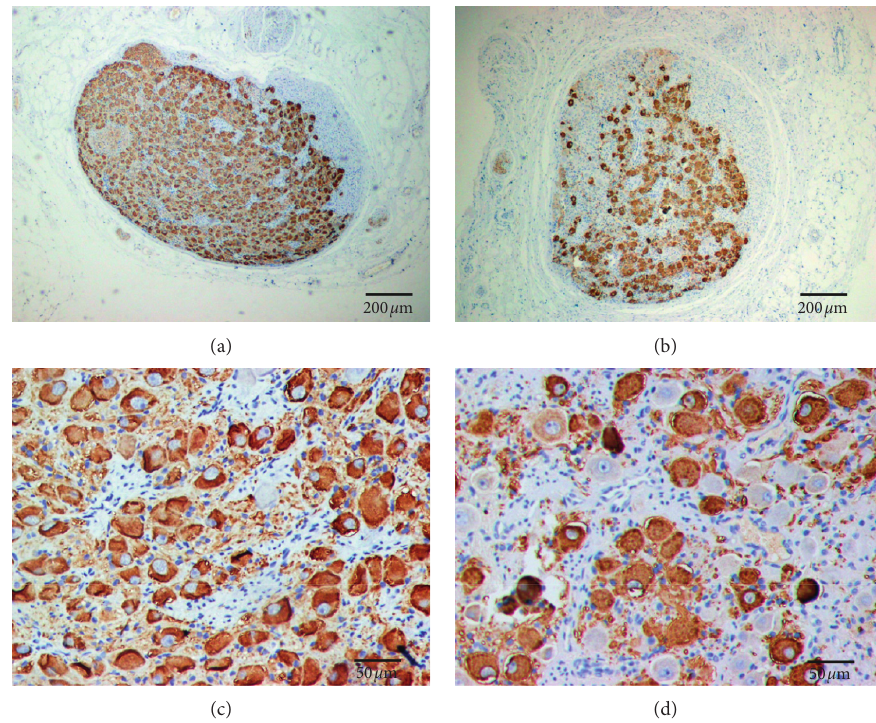
Figure 2: TH staining of LSG in both control group and experimental group. (a) The LSG of the control group seen at low magnification. (b) The LSG of the experimental group seen at low magnification. Compared with that of the control group, TH staining of LSG was weaker in the experimental group. (c) The LSG of the control group seen at high magnification. TH staining showed TH-negative ganglion cells (red arrows) and TH-positive ganglion cells (brown color) in LSG. (d) The LSG of the experimental group seen at high magnification. Compared with that of the control group, TH staining showed that the number of ganglionic cells was significantly decreased, but the quantity of TH- negative ganglion cells was significantly increased in the LSG of the experimental group. Effects of cutting upper TST on the neural remodeling of right SG